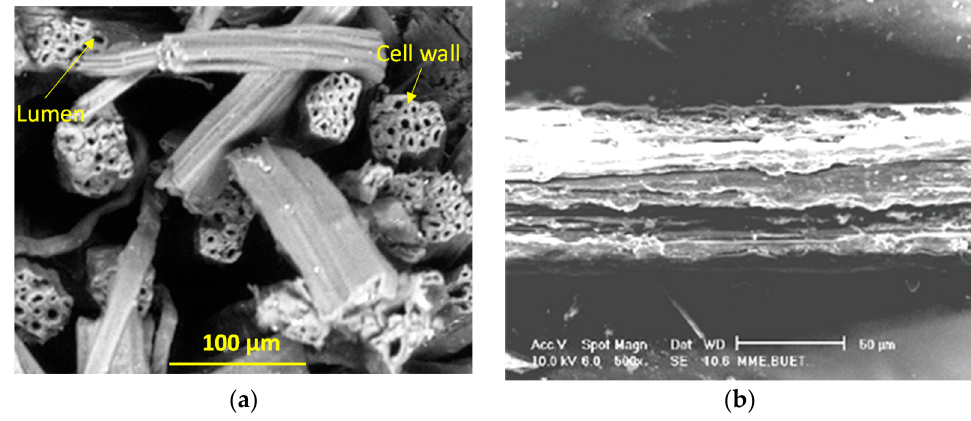
Figure 3. Jute fiber morphology: ( a ) cross-section and ( b ) surface [9].